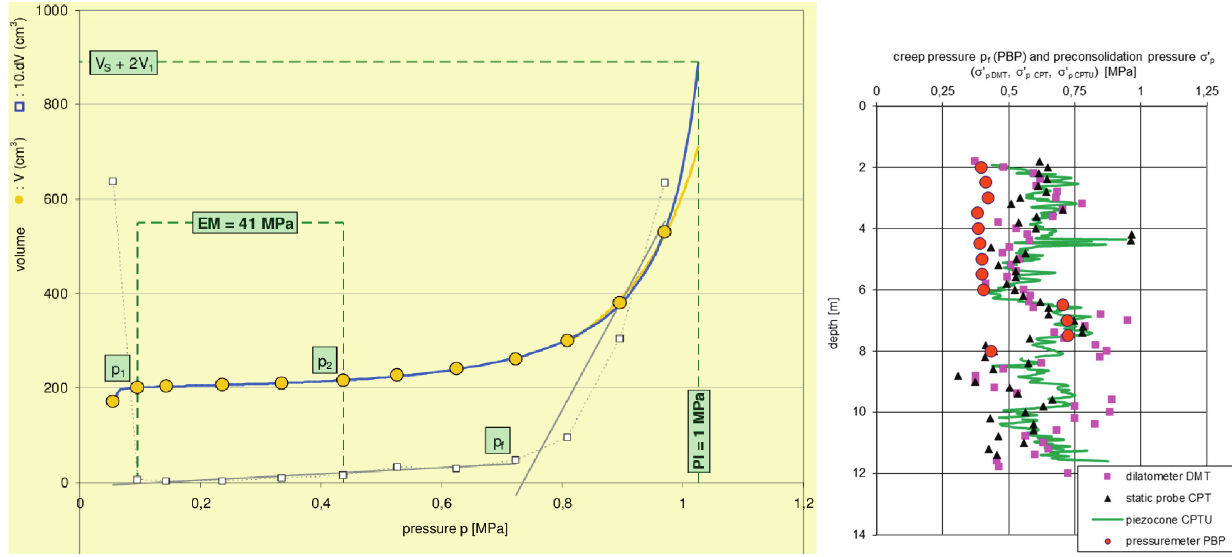
Fig. 9. Pressuremeter curve, depth 7.5 m Fig. 10. Creep pressure